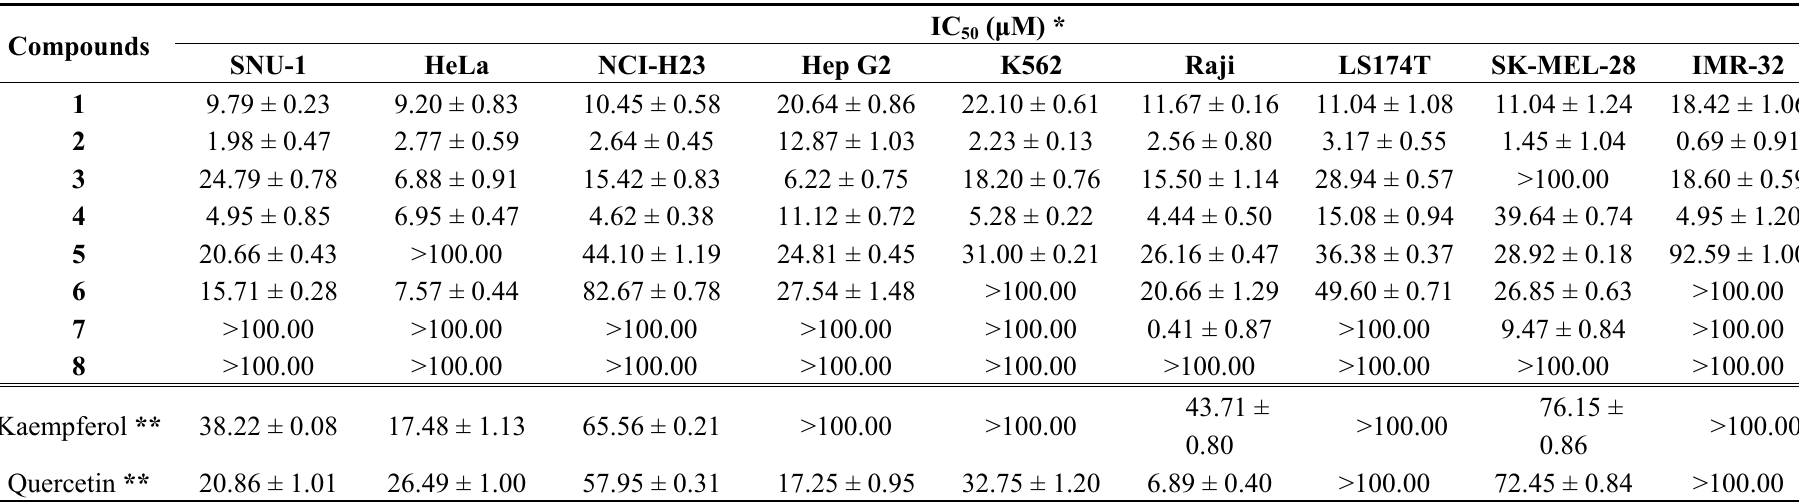
Table 1. Cytotoxicity (IC , μ M) of compounds 1–8 against SNU-1 (stomach), HeLa (cervix), NCI-H23 (lung), Hep G2 (liver), K562 50 (leukemia), Raji (lymphoma), LS174T (colon), SK-MEL-28 (skin) and IMR-32 (neuroblastoma) cells.